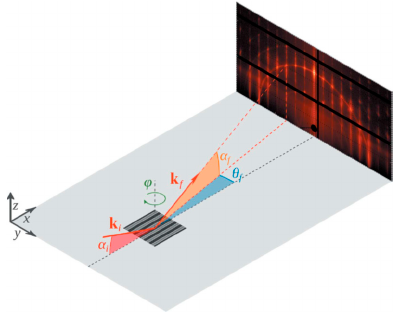
Figure 70. Geometry of grazing incidence small-angle X-ray scattering (GISAXS) experiments